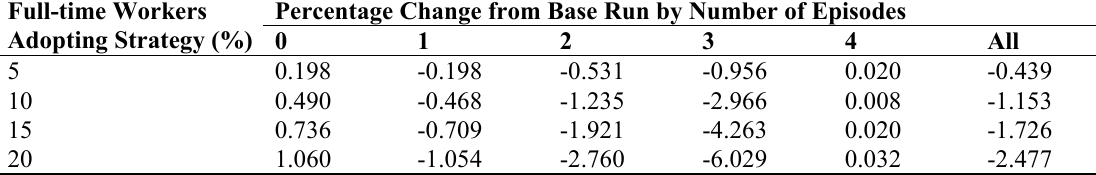
Table 8. Impact of the 10-hour workday (Scenario 1) on the daily number of non-work, out-of-home activities estimated for the heads of households in the GTA, 1986 (Scott and Kanaroglou 2003)